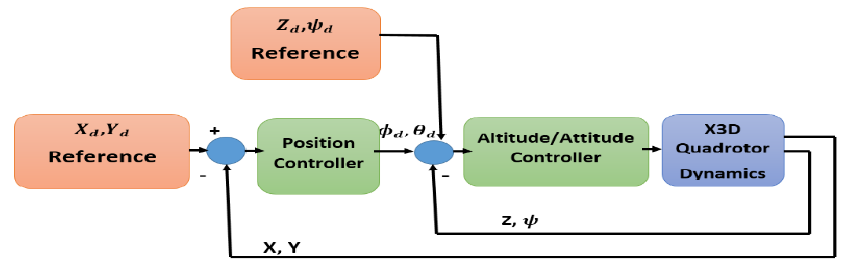
Figure 4. Closed-loop Control System for X3D Figure 4. Closed − loop Control System for X3D Quadrotor. Figure 4. Closed − loop Control System for X3D Quadrotor.